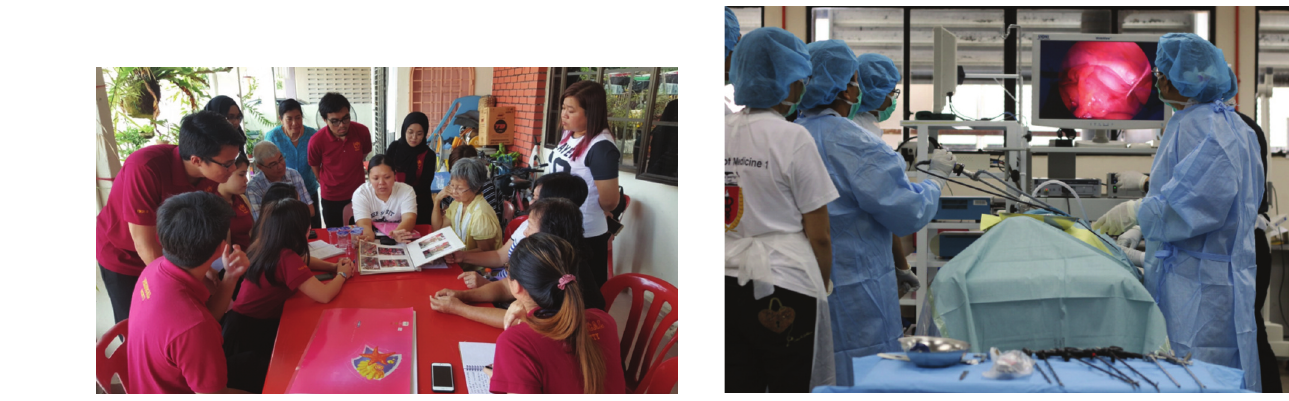
A group of medical students from a few local universities Fig. 1: visited the family of their mentor to get to know his / her family background.